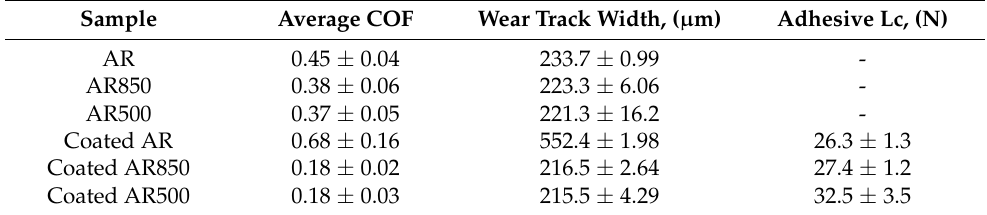
Table 5. Values of the average COF and wear track width after ball-on-wear tests for sliding time 300 s and adhesive critical for (Lc) determined by progressive scratch tests.